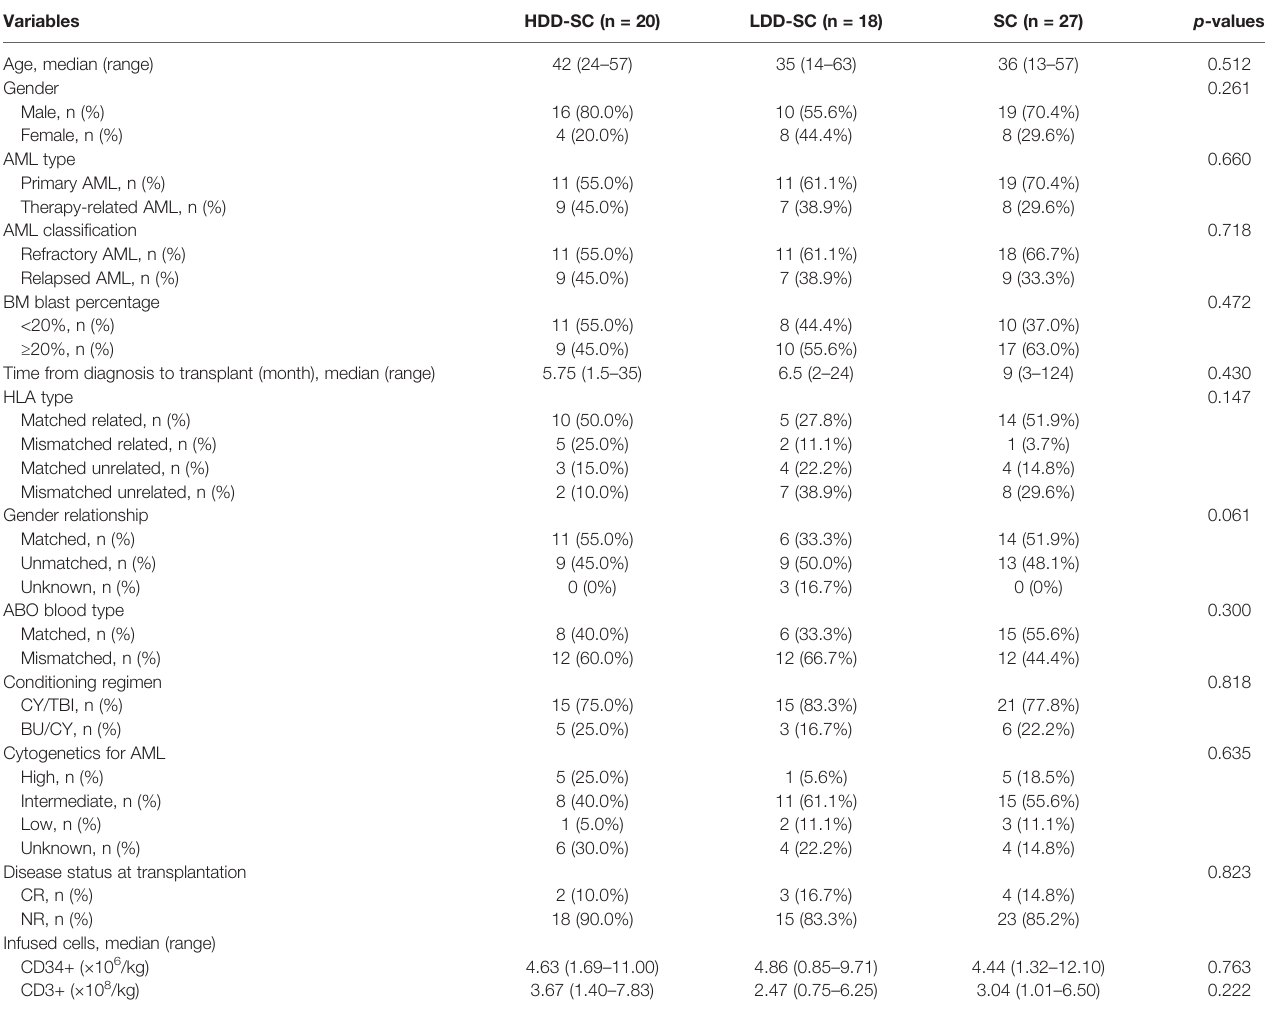
TABLE 1 | Demographics of patients in the HDD-SC group, the LDD-SC group, and the SC group. Variables HDD-SC (n = 20) Age, median